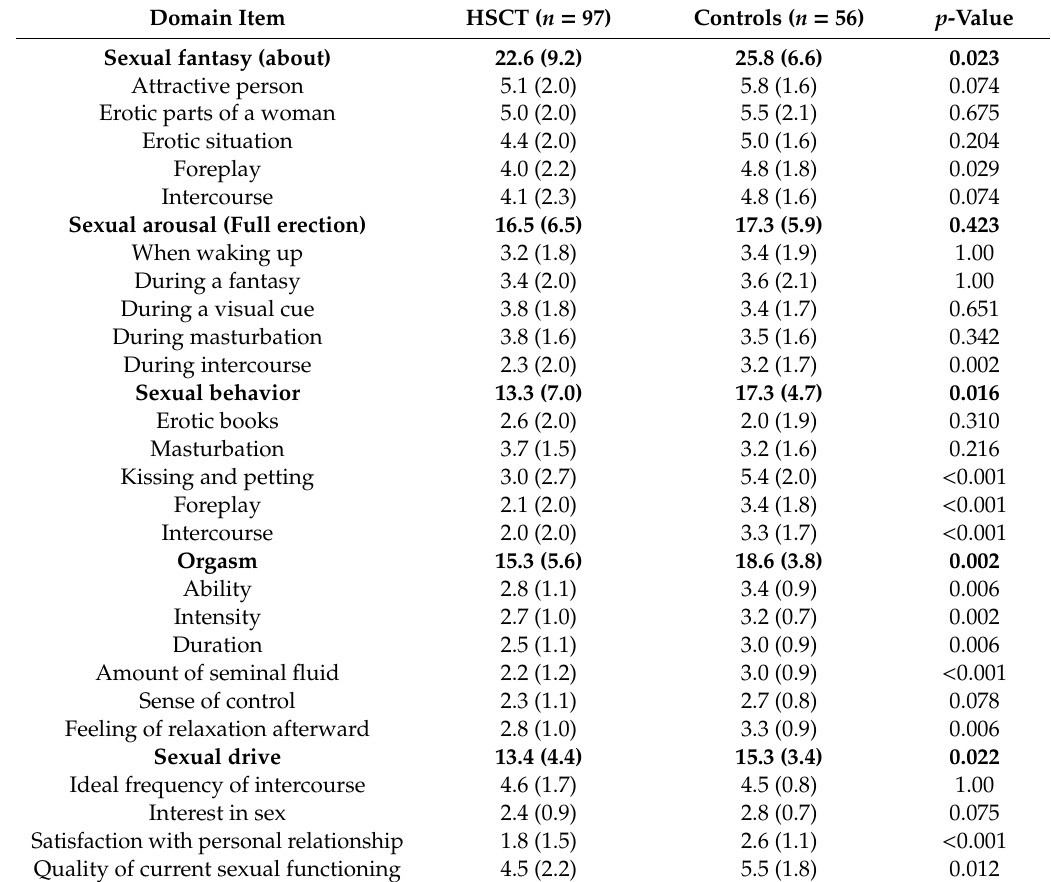
Table 2. Mean values (SD) in the Derogatis Interview for Sexual Functioning self-report between HSCT survivors and a healthy control group, with domain p -values from MANCOVA with Bonferroni-corrected post-hoc tests and item p -values from independent samples t tests corrected with the false discovery